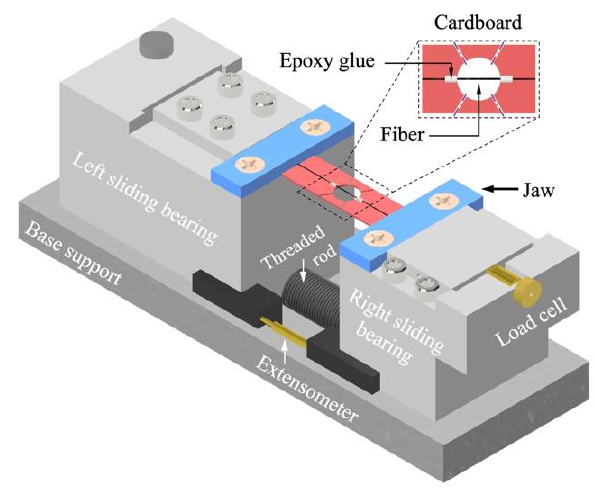
Figure 2. Single-fiber tensile experimental setup.